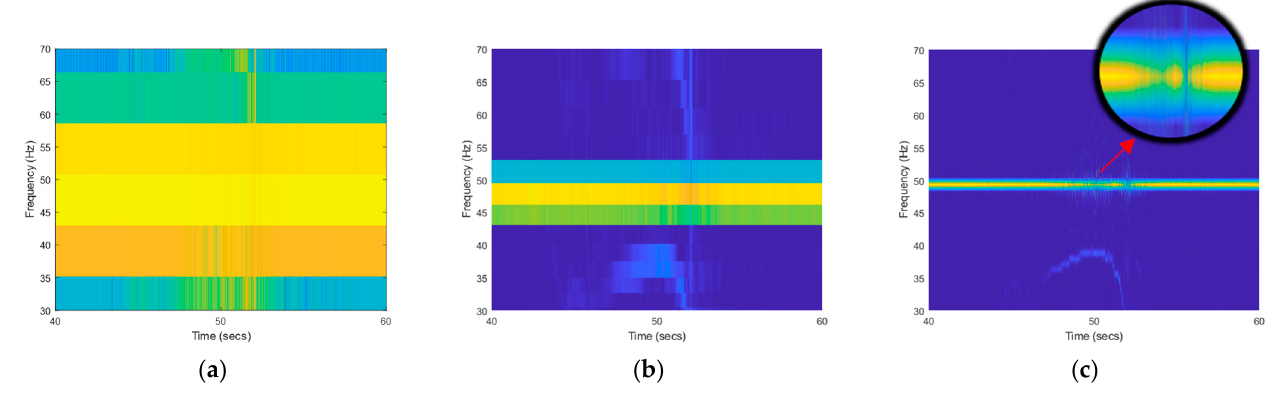
Figure 9. (40–60 s, 30–70 Hz) resolution STFT, CWT, and SSWT images. ( a – c ) Time-frequency dia- grams of STFT, CWT, and WSST are enlarged to clearly show the changes in the time-frequency diagram.